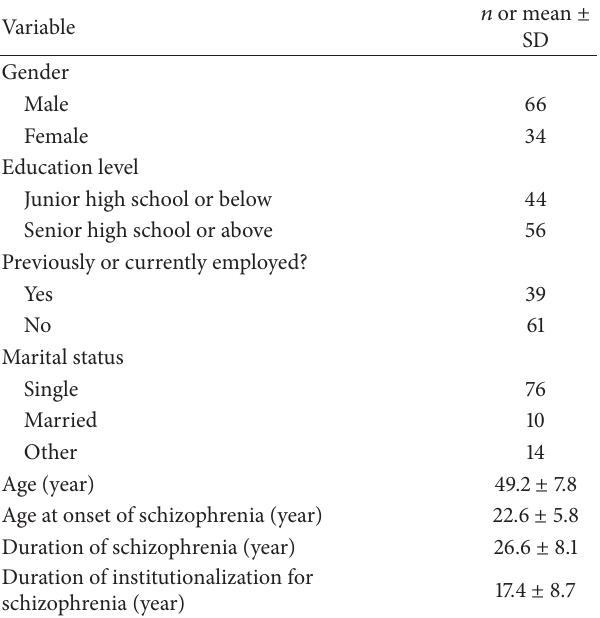
Table 1: Participants’